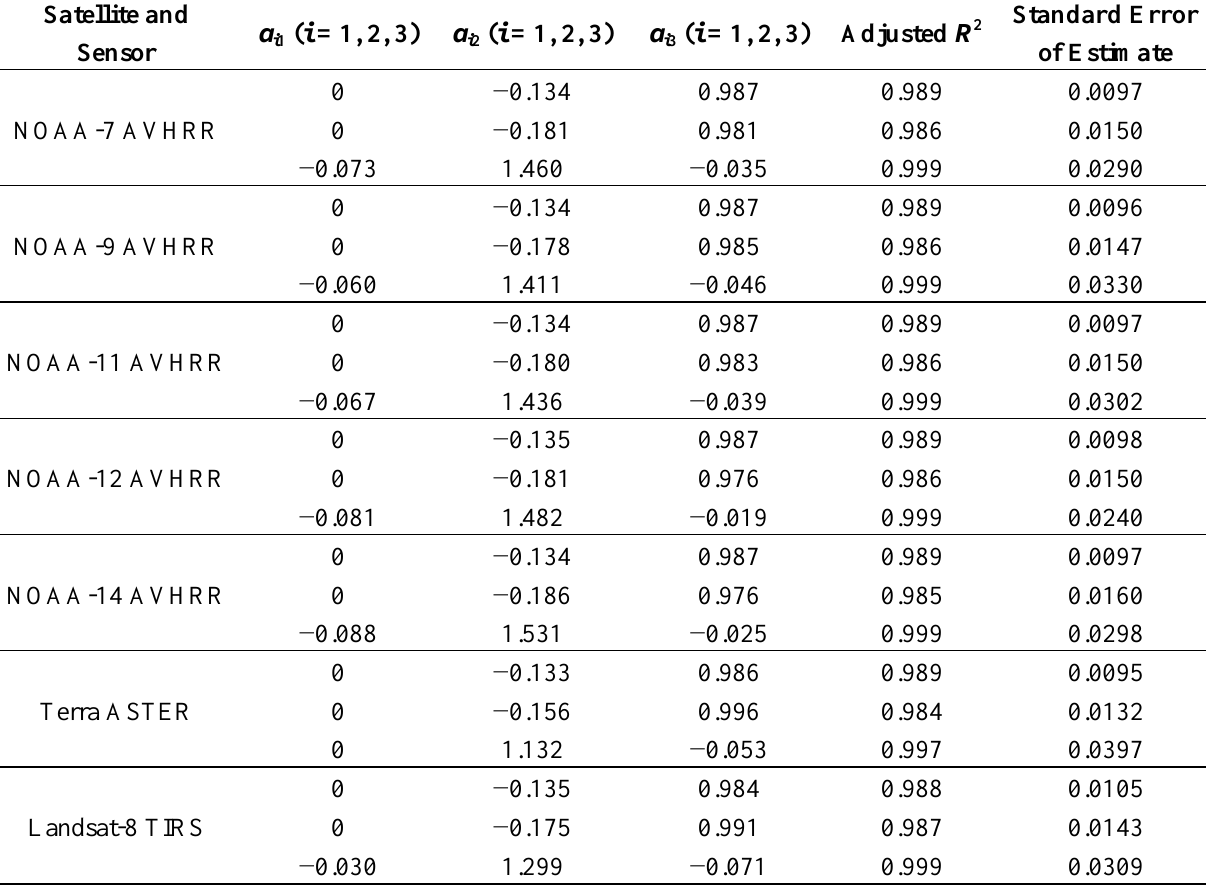
Table 10. Coefficient in Equation (14) for AVHRR, ASTER, and TIRS sensors derived from the simulation dataset generated based on GDAS atmospheric